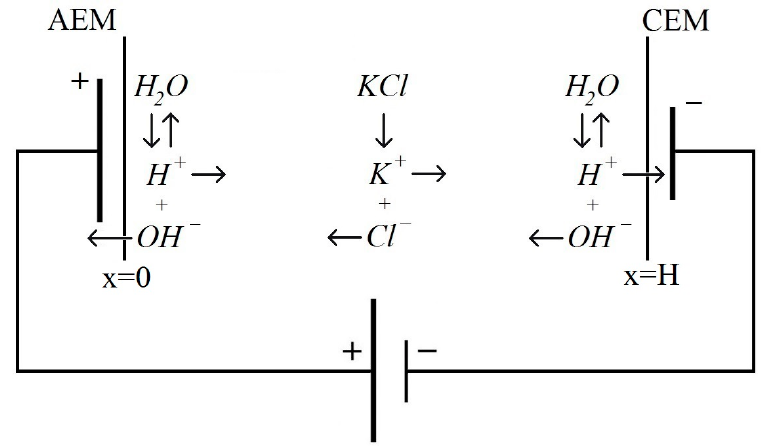
Figure 1. Schematic diagram of the cross-section of the desalination channel with complete dissociation of KCl and the dissociation/recombination reaction of water molecules that occur in the entire cross-section of the channel.